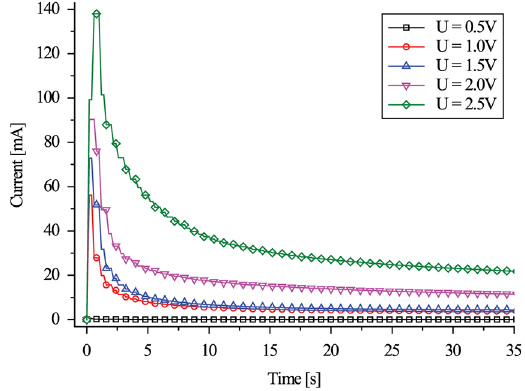
Figure 4. Electrical response of N117 based IPMC with Na + conditioned in an environment kept in RH=80%.